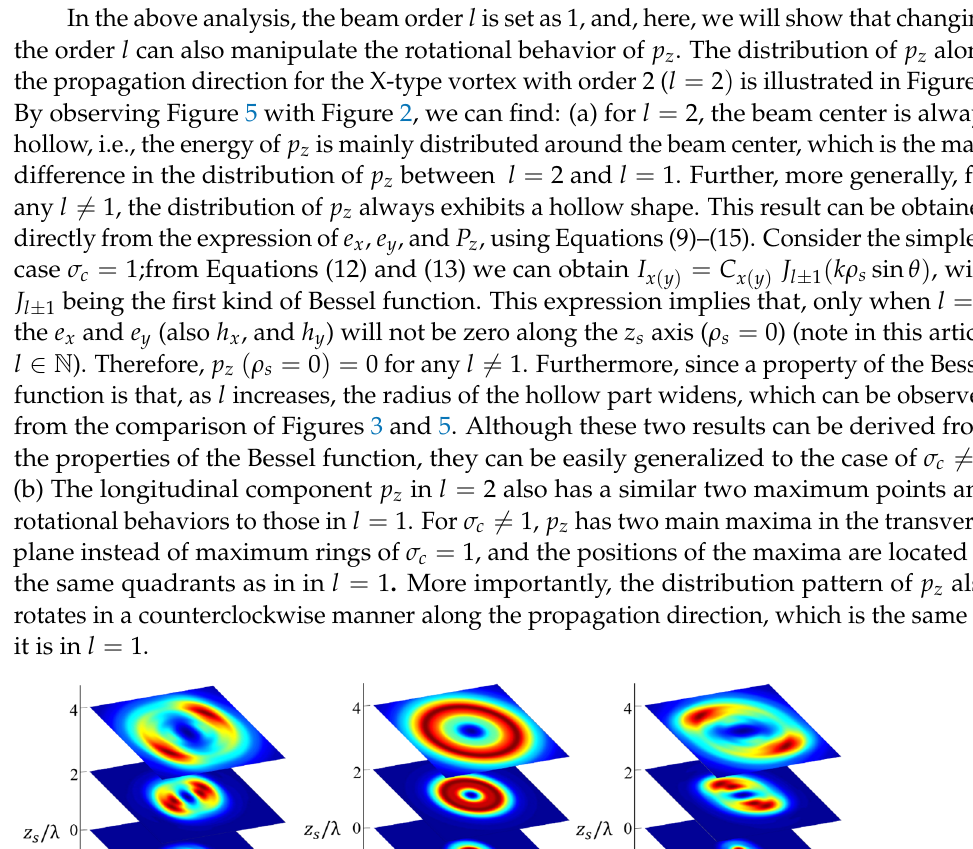
Figure 4. Variation in the rotational angle ϕ r for the longitudinal energy flow p z with the beam propagation. Here, ( a ) σ c = 0.1, 0.5; ( b ) σ c = 2, 10. In both plots l = 1.